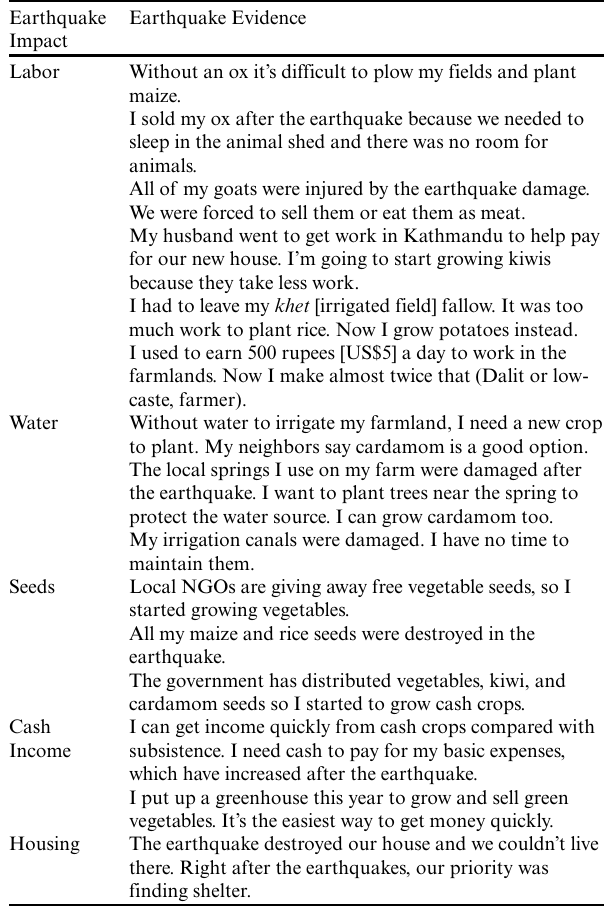
Table 3 . Individual representative quotations from multiple respondents describing earthquake impacts and responses to farming systems; generated from semistructured and open-ended interviews conducted May–July 2016 in Dolakha District,